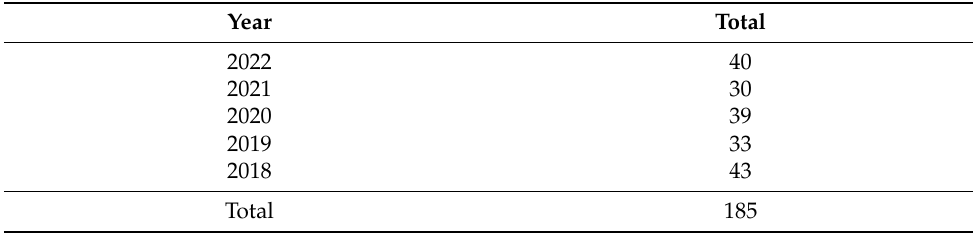
Table 3. The number of documents by